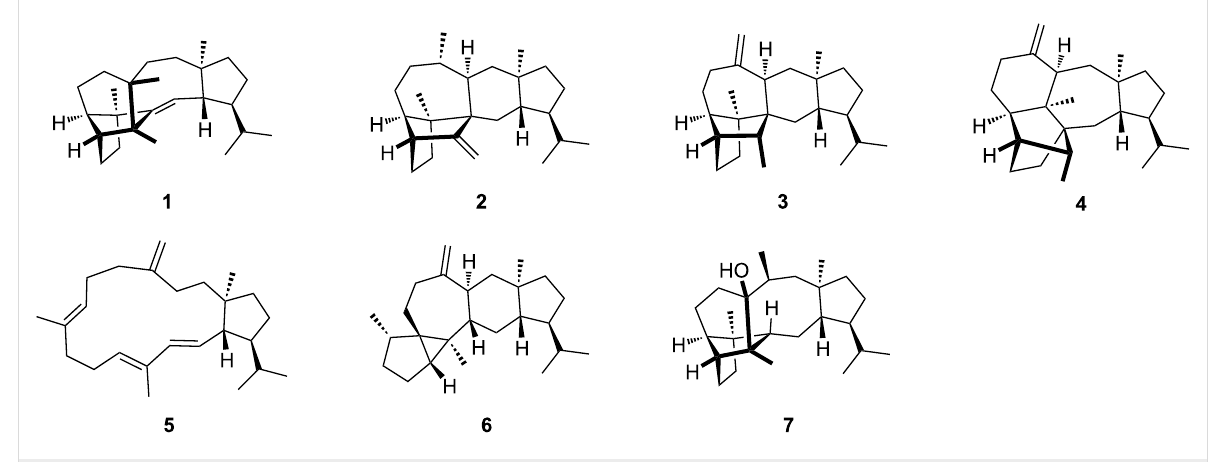
Figure 1: The structures of the bacterial sesterterpenes sestermobaraenes A–F ( 1 – 6 ) and sestermobaraol ( 7 ) from Streptomyces mobaraensis